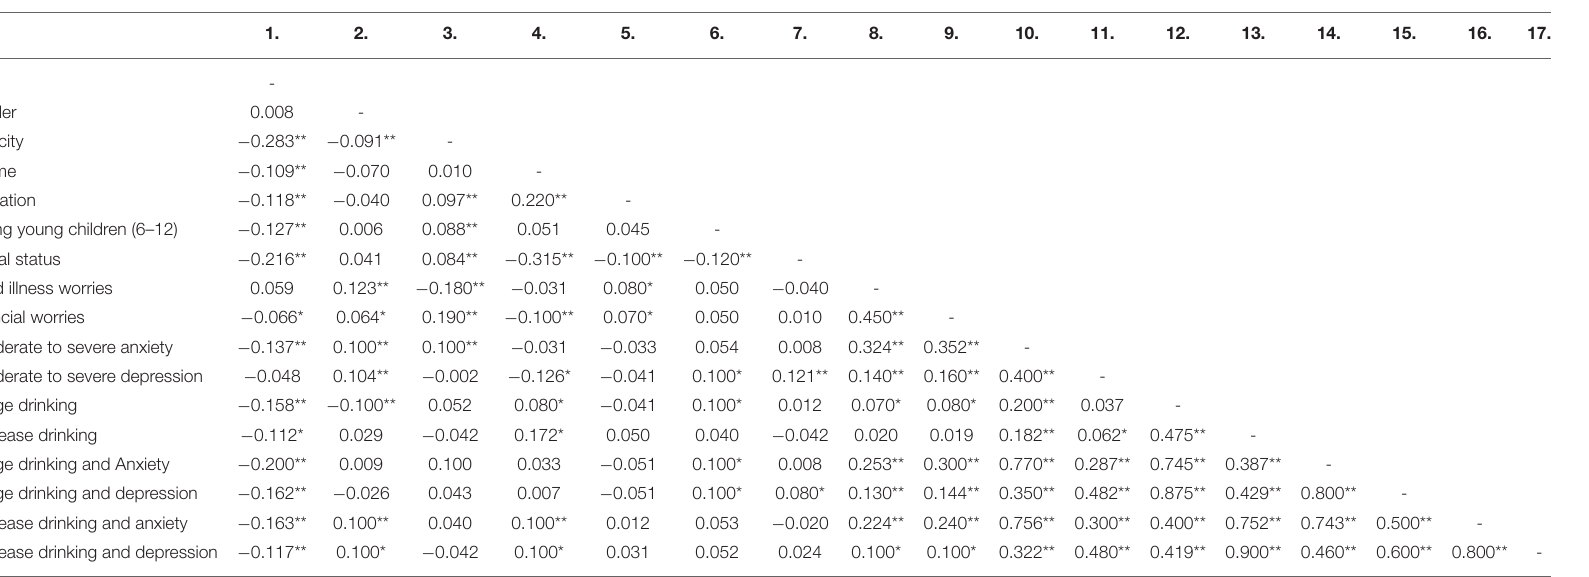
TABLE 2 | Spearman correlations between all main study